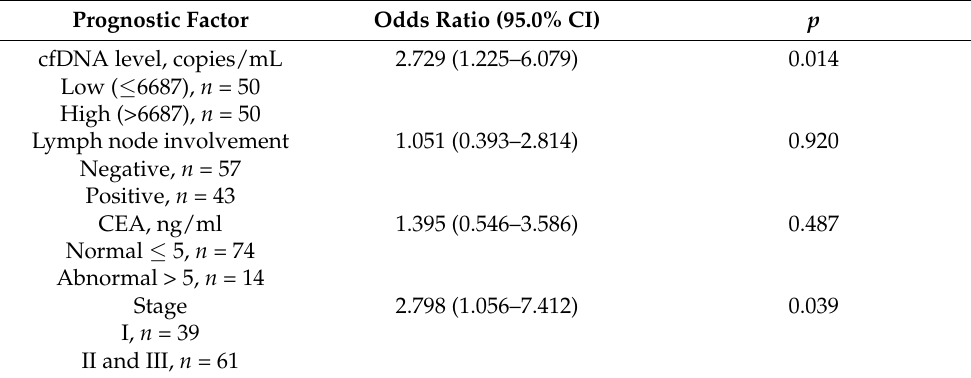
Table 3. Multivariate analysis of the independent prognostic factors in ampullary cancer patients undergoing